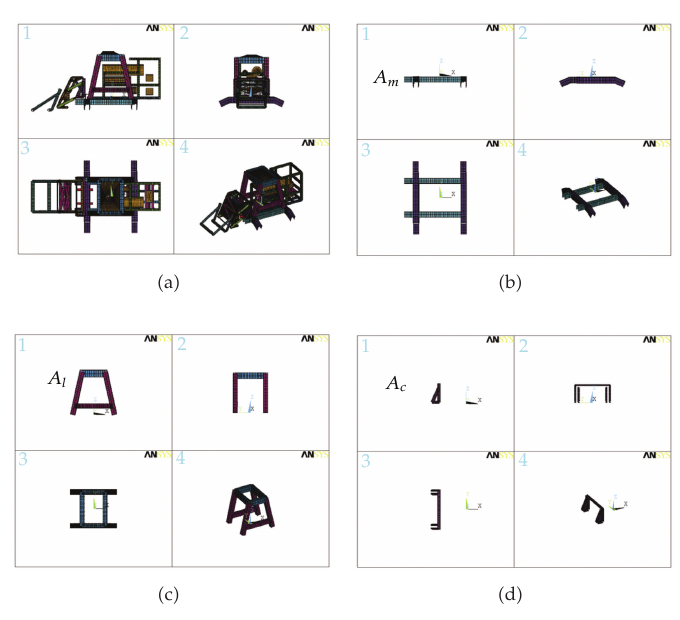
Figure 7: Configuration of chassis frame model and description of design variables.